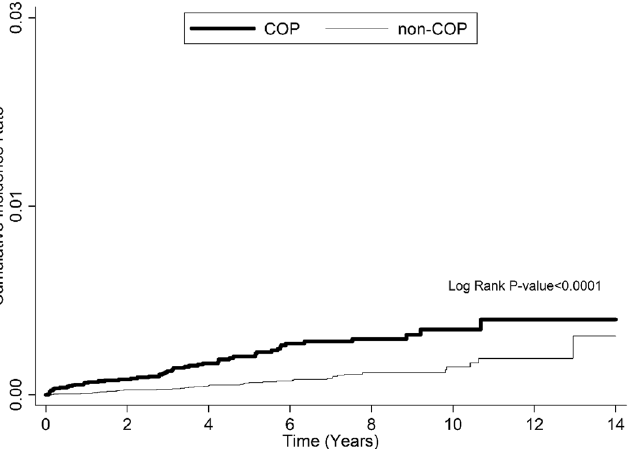
Figure 2. Comparison of the risk of adrenal insufficiency between the COP and reference (non-COP) cohorts during follow-up by Kaplan–Meier’s method and the log-rank test.